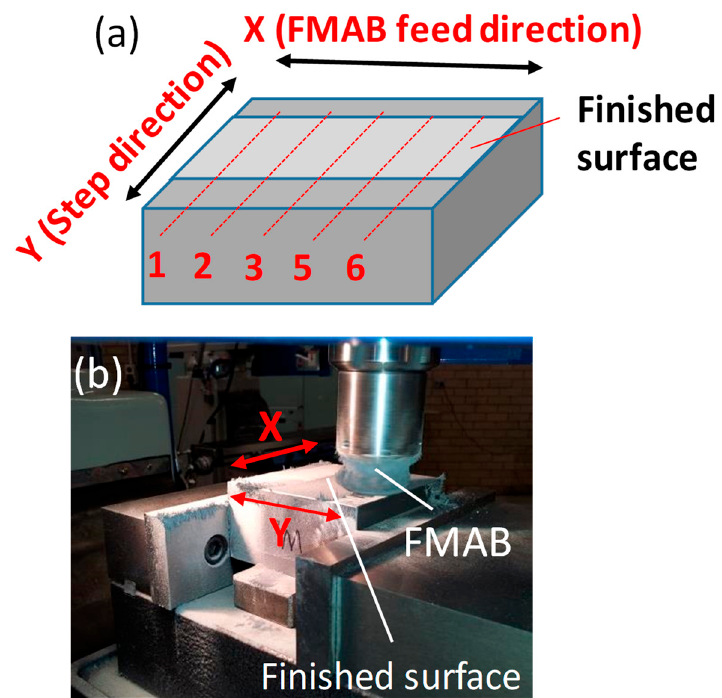
Figure 4. ( a ) Surface roughness measurement locations, and ( b ) actual finished surface.